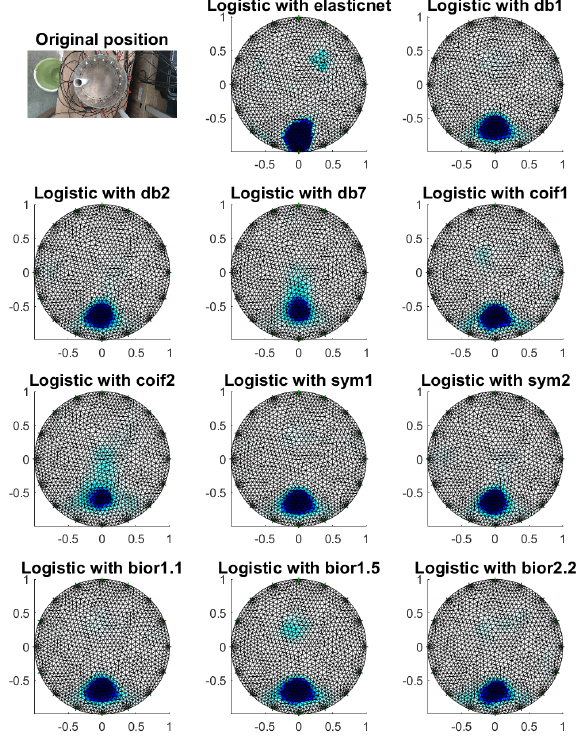
Figure 16. Image reconstruction with a phantom at electrode 9.